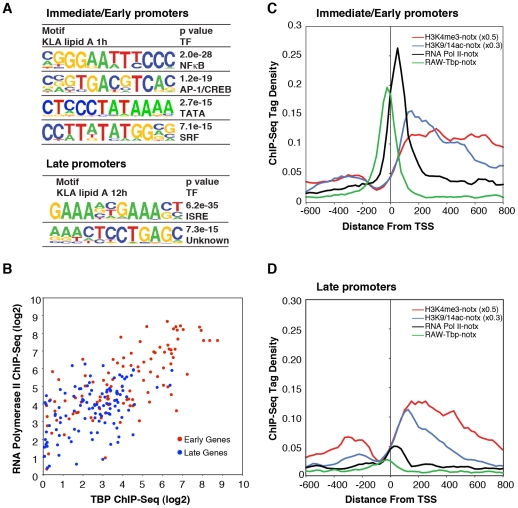
Differential use of signal-dependent transcription factors and TBP in I/E and late promoters.A. Sequence motifs identified by de novo motif analysis of the promoters of I/E and late genes. B. Scatter plots of normalized ChIP-Seq tag densities for Pol II and TBP in the interval from −100 to +250 bp from the TSS. C, D. Cumulative position-specific ChIP-Seq tag densities for H3K4me3, H3K9/14ac, Pol II and TBP determined under basal conditions for I/E (C) and late (D) genes.